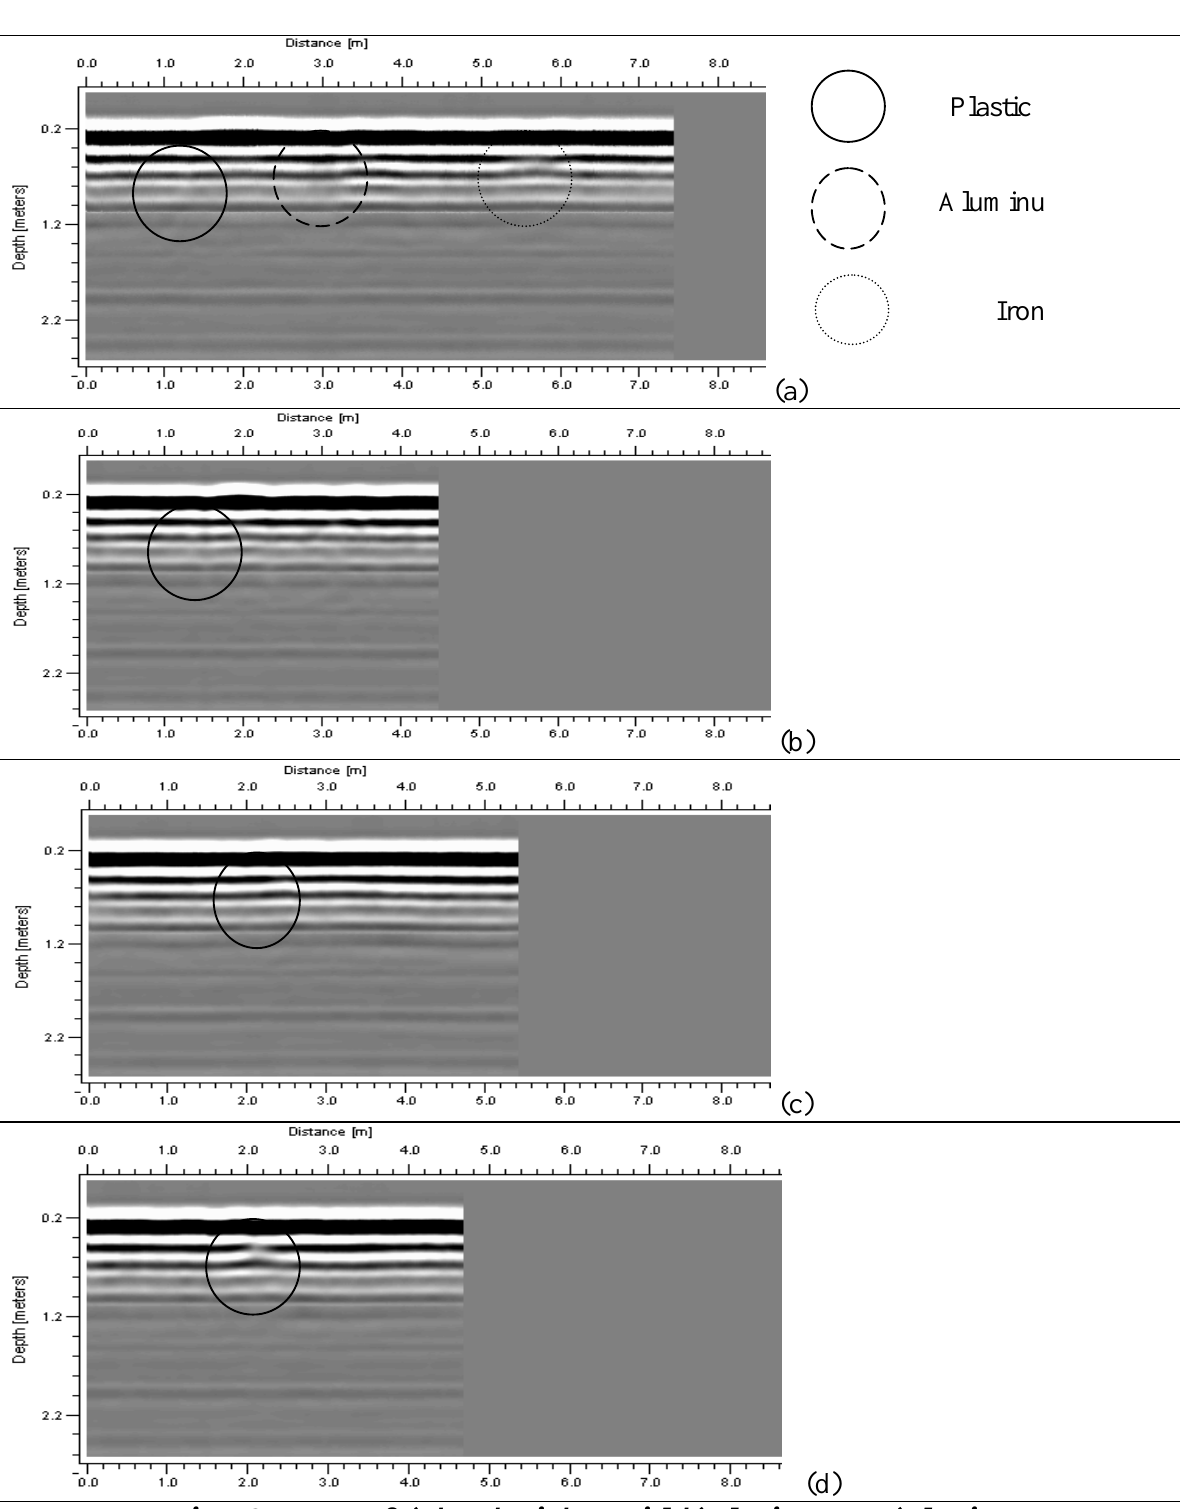
Fig.4: GPR scan of a)Three buried material, b) Plastic matter, c)Aluminum matter, d) Iron